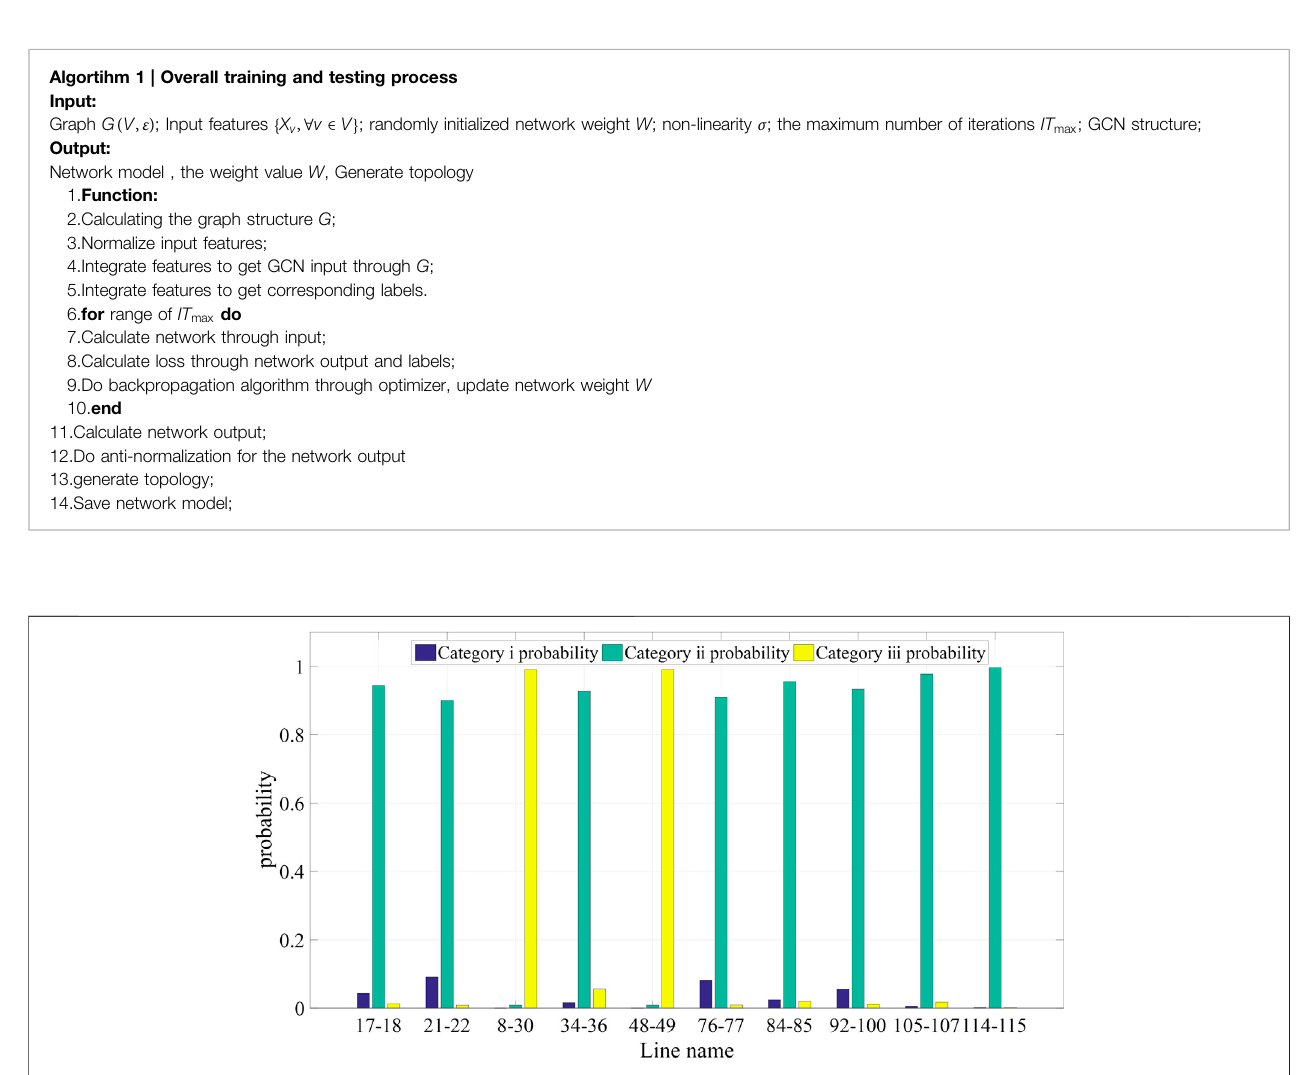
FIGURE 6 | Histogram of probability of line determination for a disconnected line or missing information.